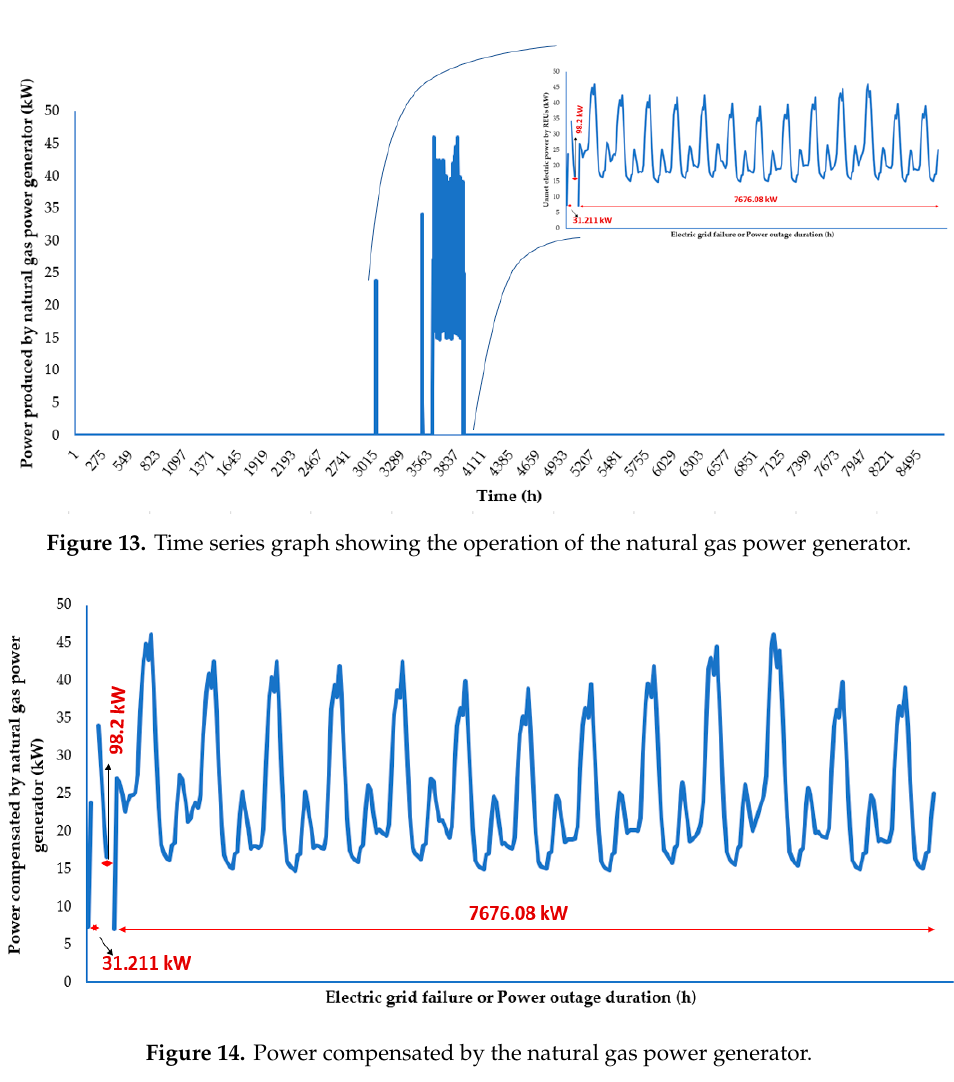
Figure 14. Power compensated by the natural gas power generator.